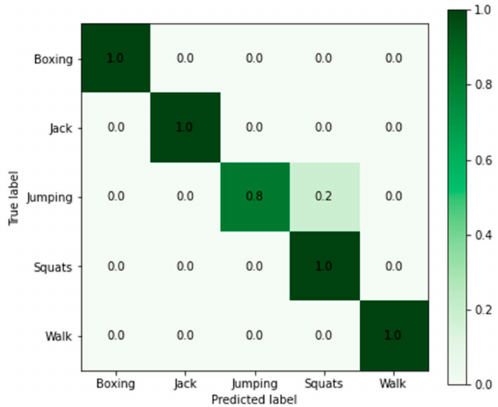
Figure 6. Confusion matrix of ST-GCN using 3D joint coordinate estimates.